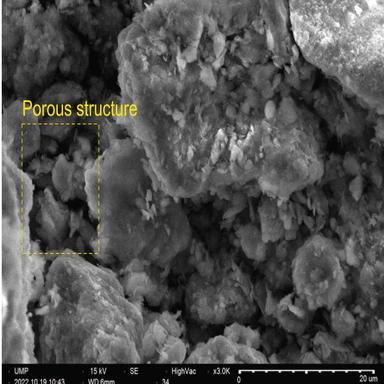
SEM micrographs of clayey sample.